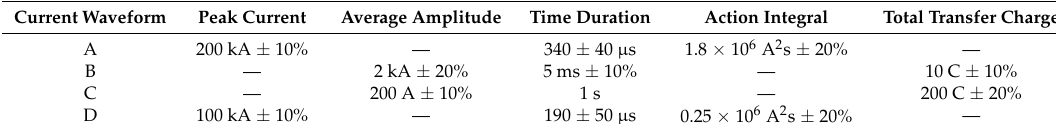
Figure 4. A, B, C, and D current waveforms. Table 2. Parameters of impulse electrical current waveforms.